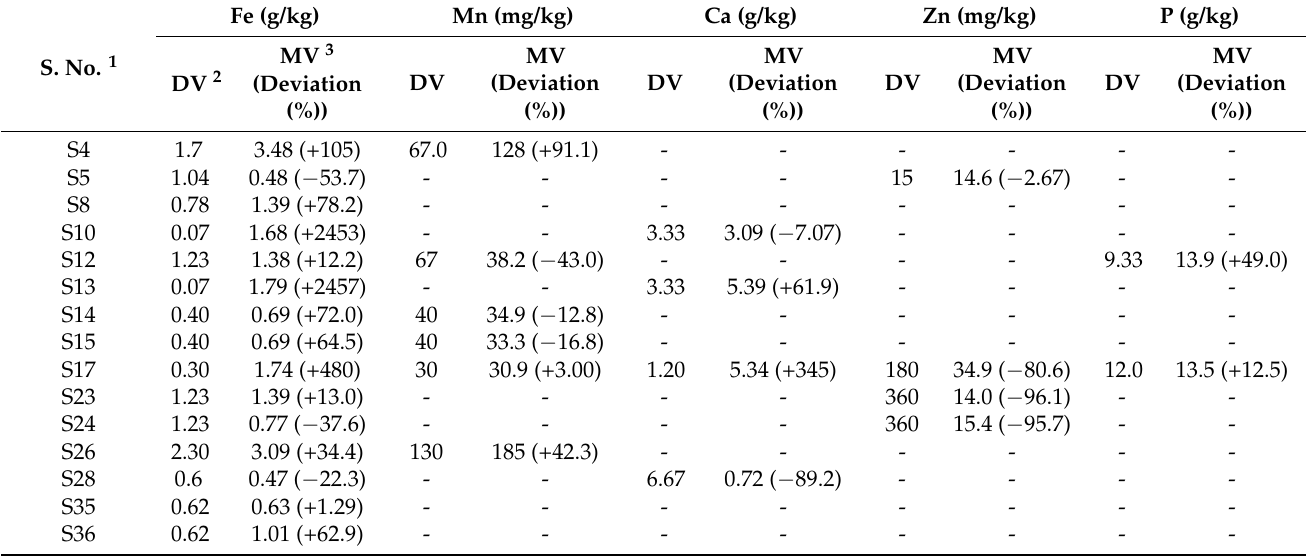
Table 4. Compliance with Spirulina declared nutrient values (% deviation).